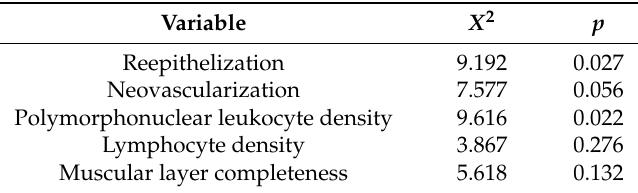
the groups. Kruskal-Wallis test p < 0.05 ( X 2 : Chi-square).